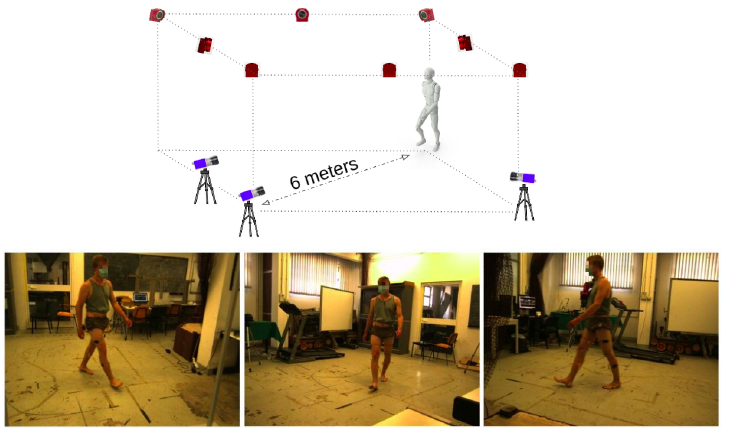
Figure 2. Setup adopted for data acquisition. The upper panel shows the sketch of the setup with the position of the 8 infrared (red) and 3 RGB (blue) cameras. The lower panel shows the three view points of the RGB